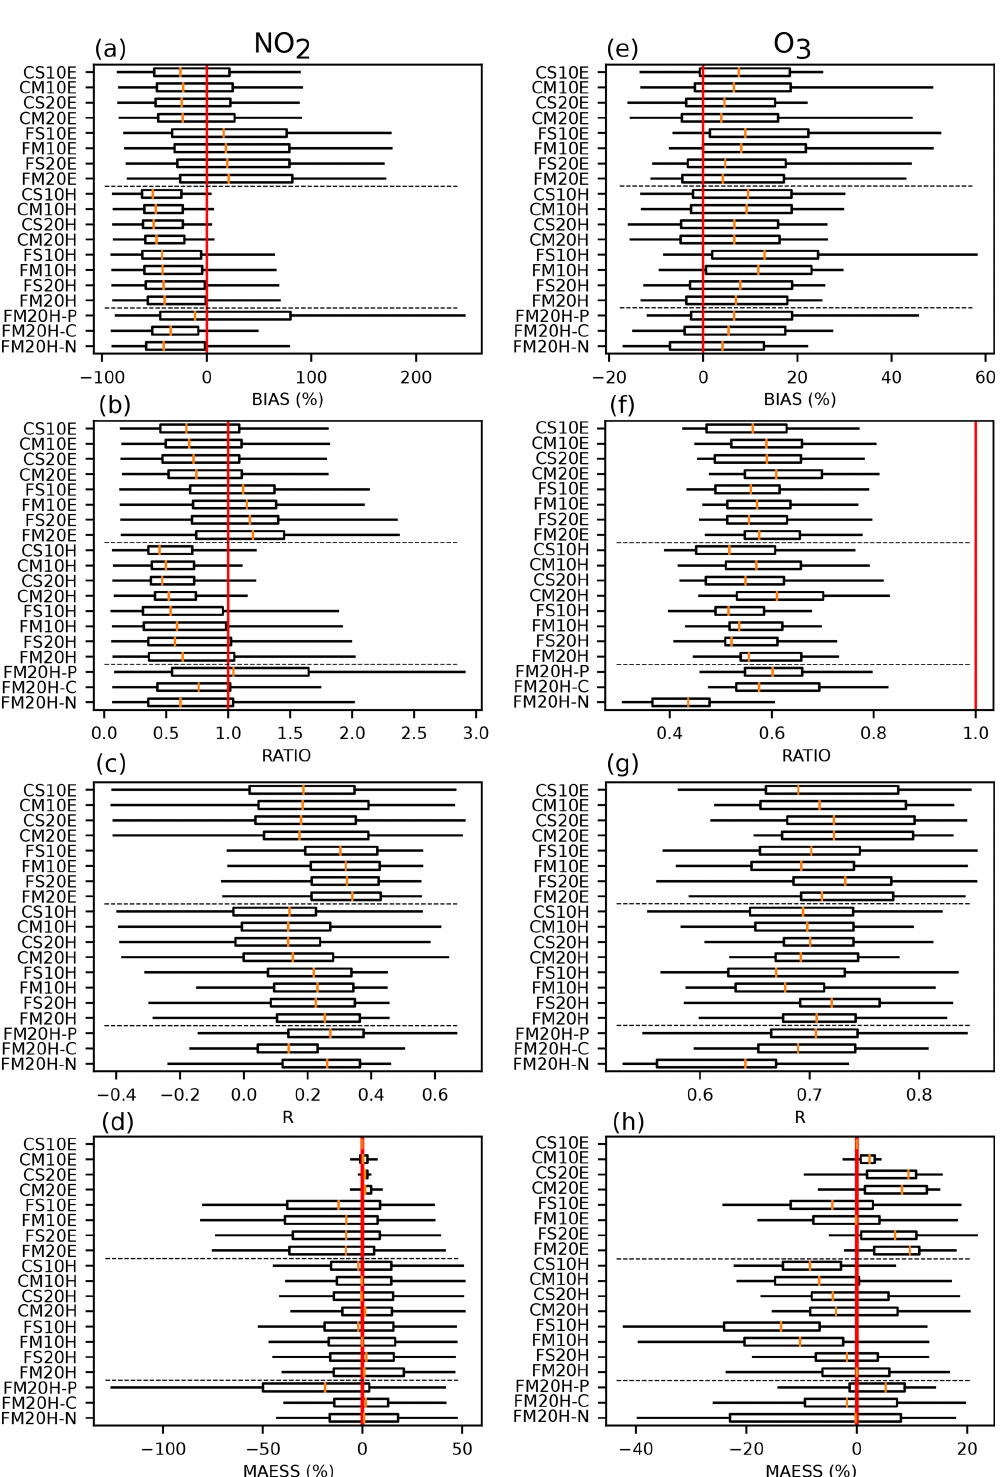
Figure 4. Temporal verification results for daily near-surface maximum NO 2 (a–d) and O 3 (e–h) . (a, e) Percentage bias (BIAS), (b, f) Pearson correlation coefficient ( R ), (c, g) ratio of standard deviation (RATIO), (d, h) mean absolute error skill score (MAESS) with reference to the base experiment CS10E. Box plots are calculated upon the pointwise verification results at all available stations. Experiments are explained and grouped as in Table